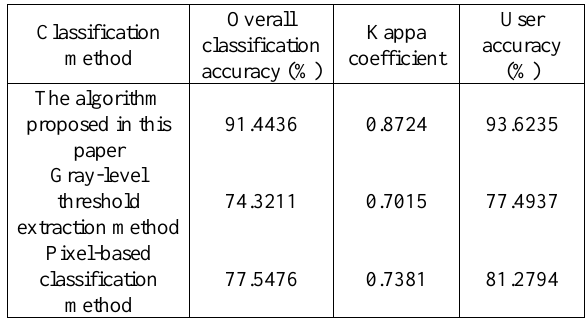
Table 1. The comparison of the overall classification accuracy of various classification